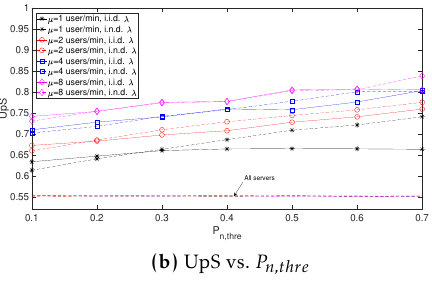
Figure 5. Impacts of service